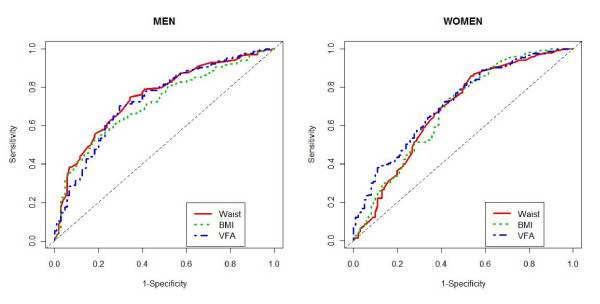
ROC curves to identify ≥2 metabolic risk factors other than WC. In both men and women, the AUC values for VFA did not show higher values compared to WC and BMI.